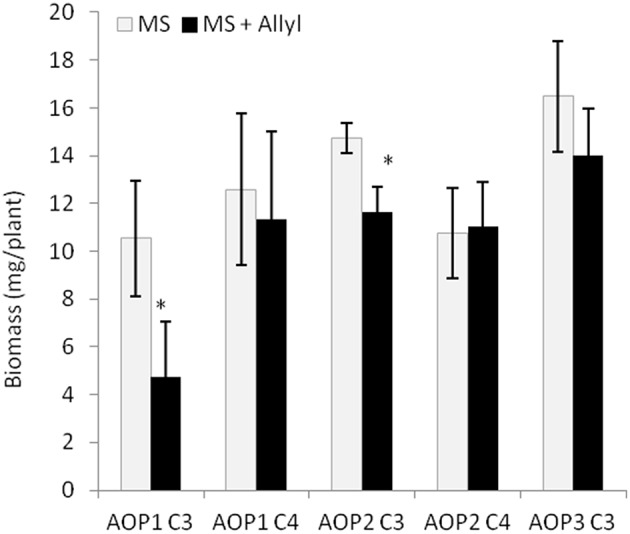
GSL chemotype interacts with exogenous Allyl treatment to influence plant biomass of Arabidopsis accessions. Quantification of fw (mg tissue/plant) from 15-day-old seedlings from 96 Arabidopsis natural accessions fed with 50 μM of allyl GSL using MS media with 1% sucrose. The population was grouped by their GSL chemotype profile generated by the combination of variation at GS-AOP (alkenyl, hydroxyalkyl, and methylsulfinyl) GS-Elong (3C vs. 4C). The sub-populations generated are labeled by their predominant glucosinolate; AOP1 C3 accumulates 3-methylsulfinylpropyl, AOP1 C4 accumulates 4-methylsulfinylbutyl, AOP2 C3 accumulates allyl. AOP2 C4 accumulates But-3-enyl and AOP3 C3 accumulates 3-hydroxypropyl (Table S1). None of the studied accessions displayed the AOP3 C4 chemotype accumulating 4-hydroxybutyl. The bar chart represents the mean fw and the error bars represent the standard deviation among the accessions within each chemotype. *shows GSL haplotypes that had a significant difference in plant biomass response to exogenous allyl GSL using post hoc Tukey's t-test with P ≤ 0.05 from the ANOVA analysis.